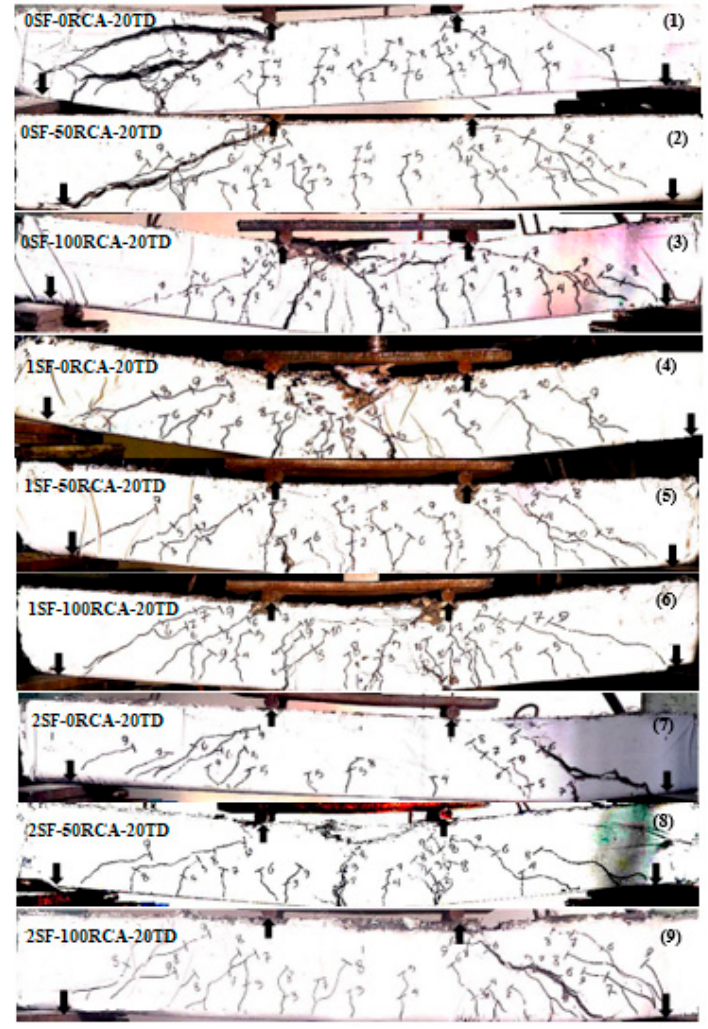
Figure 17. Failure and crack propagation in specimens with a 200 mm shear rebar spacing.